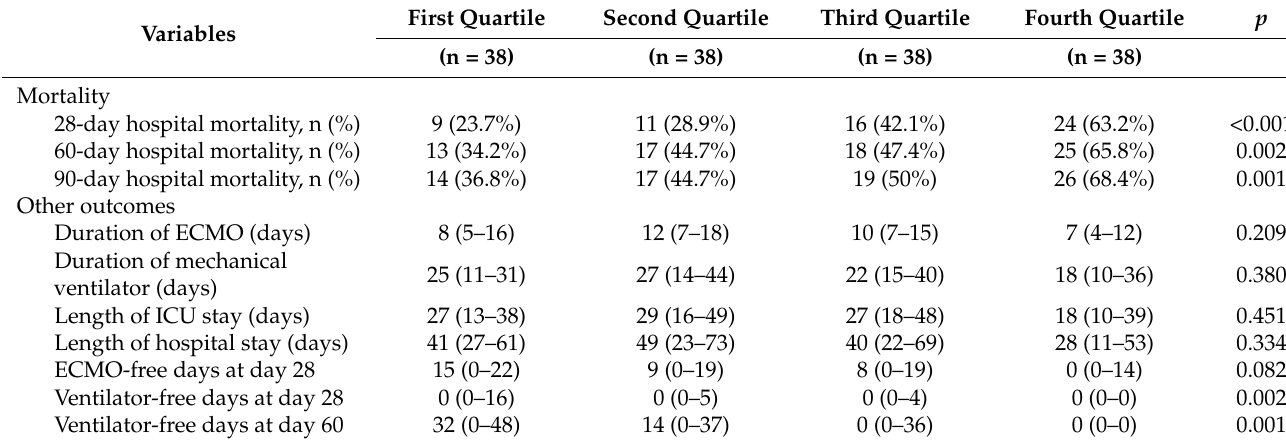
Table 3. Clinical outcomes as a function of cumulative fluid balance at 3 days after ECMO.